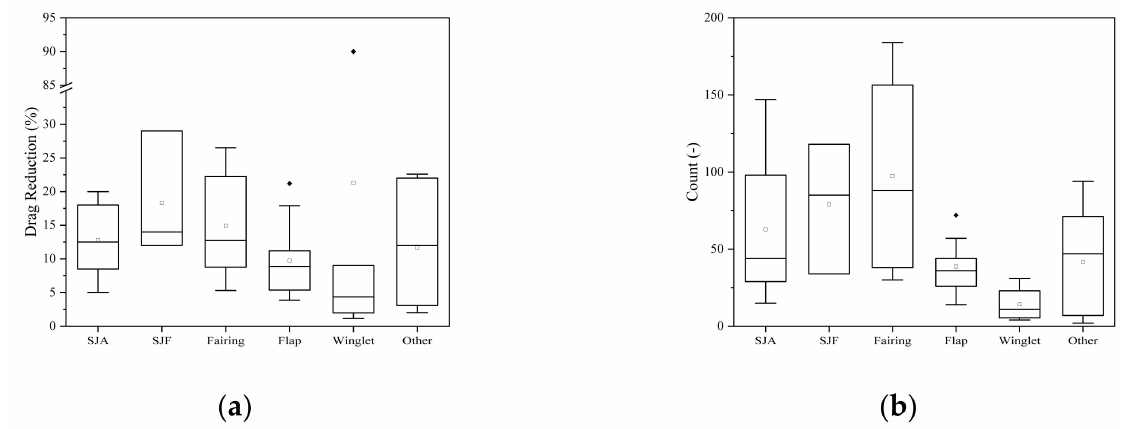
Figure 7. Reduced drag boxplot in ( a ) percentage and ( b ) in Count (line is median, (cid:3) mean, (cid:7) peaking